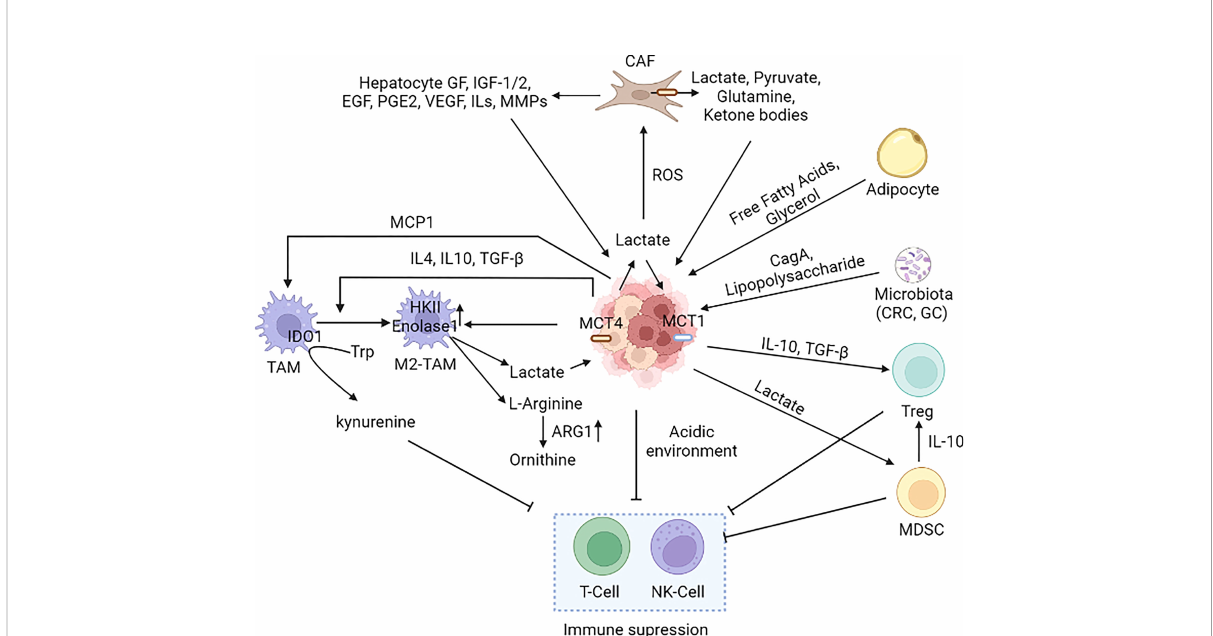
FIGURE 6 Cancer microenvironment in metabolic reprogramming. Several cell types such as macrophages, neutrophils, MDSCs, Treg, DC, T-cell, NK-cell, adipocytes, and CAFs present in the tumor microenvironment alter the metabolic reprogramming of cancer cells. Immune cells present in the TME have both pro and anti-tumor effects; however, the cancer cells induce the pro-tumorigenic phenotype (M2-TAM and M2-TAN). Cancer cells induce CAFs to secrete lactate in the TME leading to an acidic environment that suppresses the immune cells (242, 250, 252, 291 – 301). [MCT1: Monocarboxylate transporter 1, MCT4, Monocarboxylate transporter 4; CAF, Cancer-associated fi broblast; M2-TAM, M2 Type Tumor- associated macrophages; NK cell, Natural killer cell; MCP1/CCL2, Monocyte chemoattractant protein-1/Chemokine (C-C motif) ligand 2; IDO, Indoleamine-pyrrole 2,3-dioxygenase; MDSC, Myeloid-derived suppressor cells; Treg, T regulatory cells; IGF, Insulin-like Growth Factor; EGF, Epidermal growth factor; VEGF, Vascular endothelial growth factor; IL-Interleukin, PGE2-Prostaglandin E2; TGF- b , Transforming growth factor beta, MMP: Matrix metalloproteases, CRC, Colorectal cancer; GC, Gastric